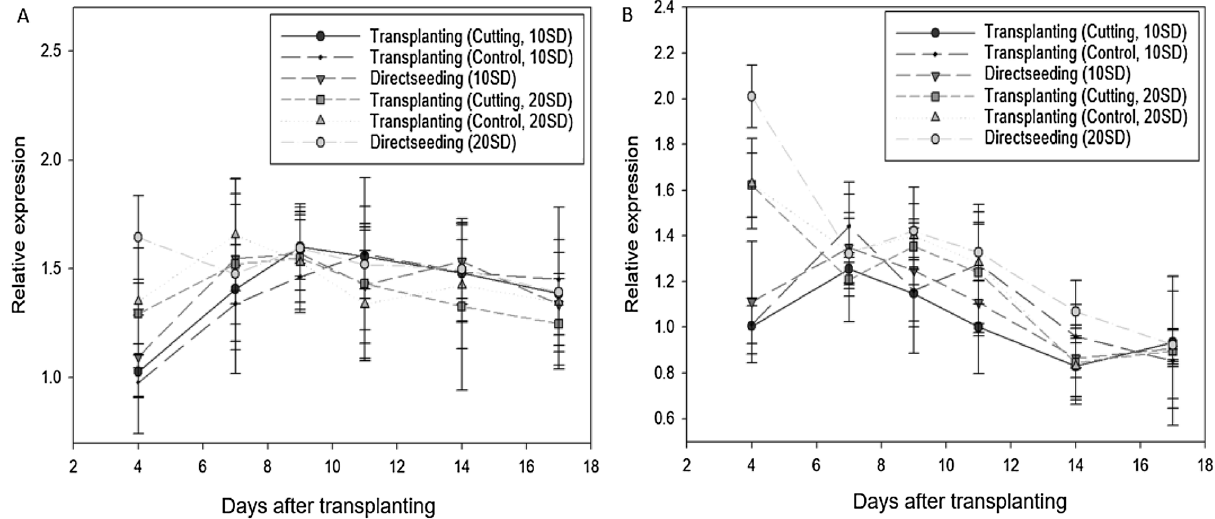
Figure 9. Changes in Hd3a gene expression after transplanting in response to root cutting conditions and seedling age. ( A ) Odae, ( B ) Saenuri. Error bars are standard